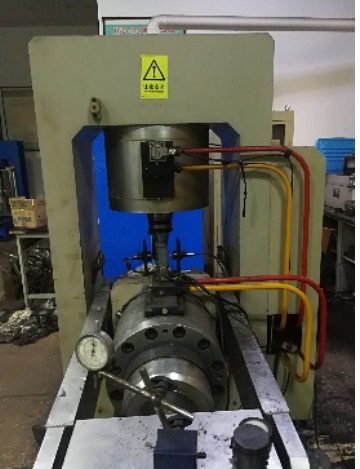
Figure 3. RMT-150 rock test system.